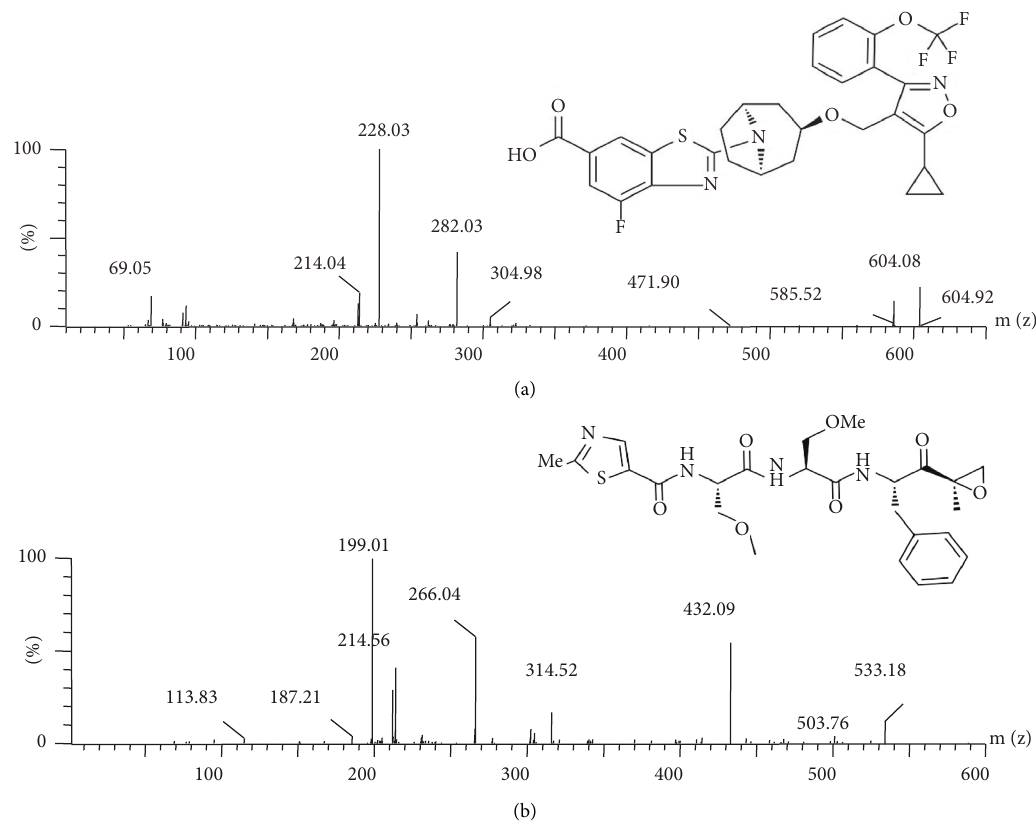
Figure 1: In the present work, the mass spectra of tropifexor (a) and oprozomib (b). Table 1: The mass spectral parameters, cone voltage (CV), collision energy (CE), and retention time (RTs) of tropifexor and ISTD.